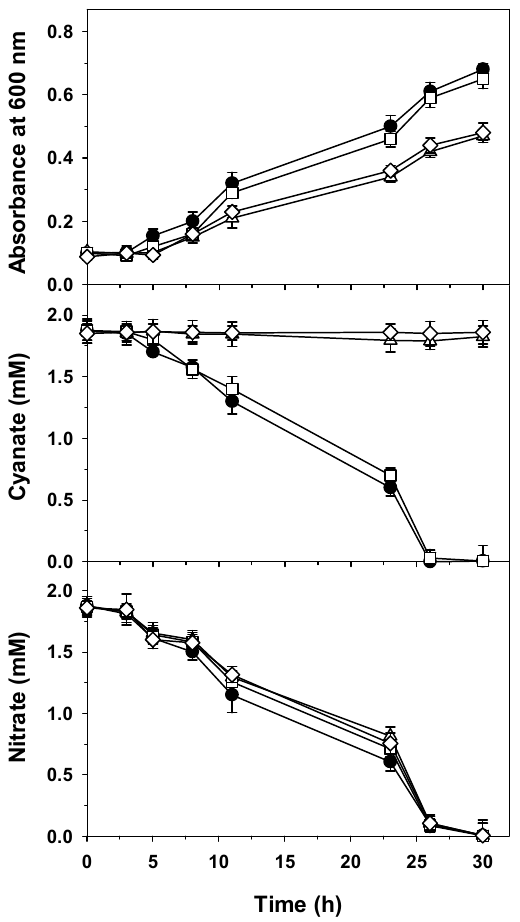
Figure 3. Growth, and cyanate and nitrate consumption of the wild-type strain ( (cid:8) ) and the CynF − ( (cid:52) ), CynBD − ( (cid:3) ), and CynS − ( ) mutants of P. pseudoalcaligenes CECT5344 in media with cyanate and nitrate. Cells were grown in the minimal medium M9 with 2 mM cyanate and 2 mM nitrate as nitrogen sources, and at the indicated times, the bacterial growth (A 600 ) and cyanate and nitrate concentrations were determined. Error bars show standard deviations of three independent replicates.